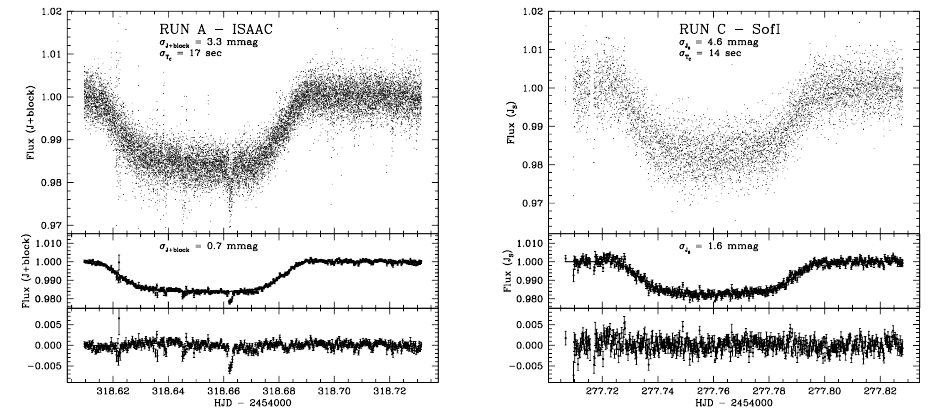
Figure 1.: Light curves (LC) of two WASP-2b transits from ISAAC (left) and SofI (right), with 86 × 0.6 sec and 800 × 1.5 sec. The unbinned LCs (top) have RMS of 3.3 and 4.6 mmag, respectively. These are reduced to 0.7 and 1.6 mmag for binning of 20 sec (middle). The residuals for the binned LCs are shown at the bottom.